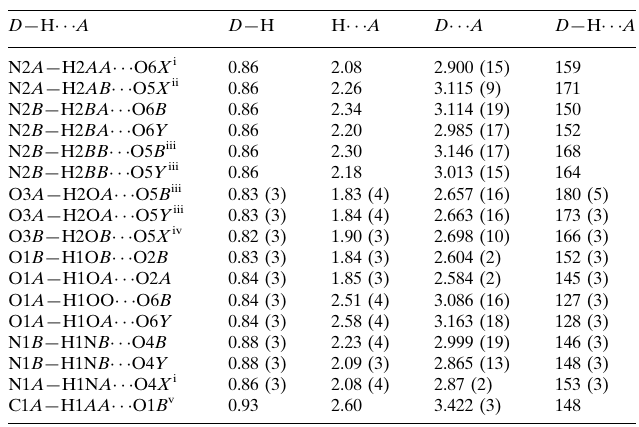
Hydrogen-bond geometry (A˚ , (cid:4)